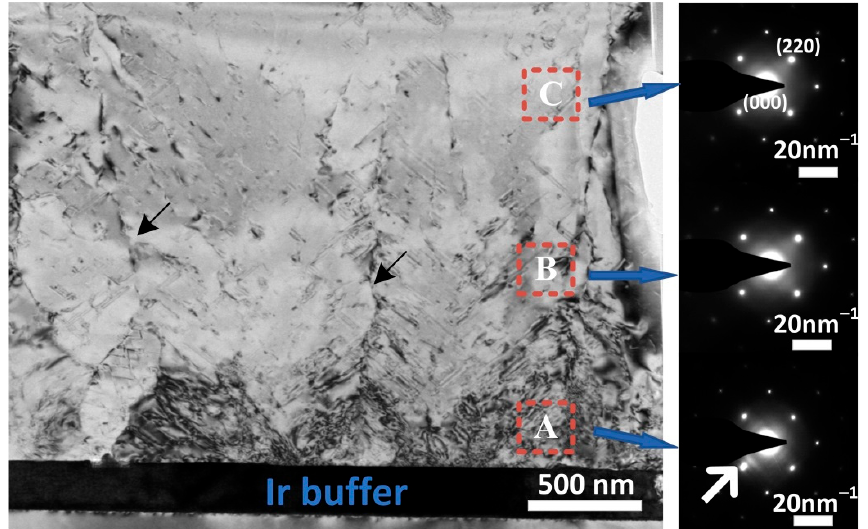
Figure 4. TEM image of heteroepitaxy diamond on Ir (001)/Al 2 O 3 substrate along [110] zone axis (area A: near diamond/Ir interface; area B: above the diamond/Ir interface; area C: in the diamond